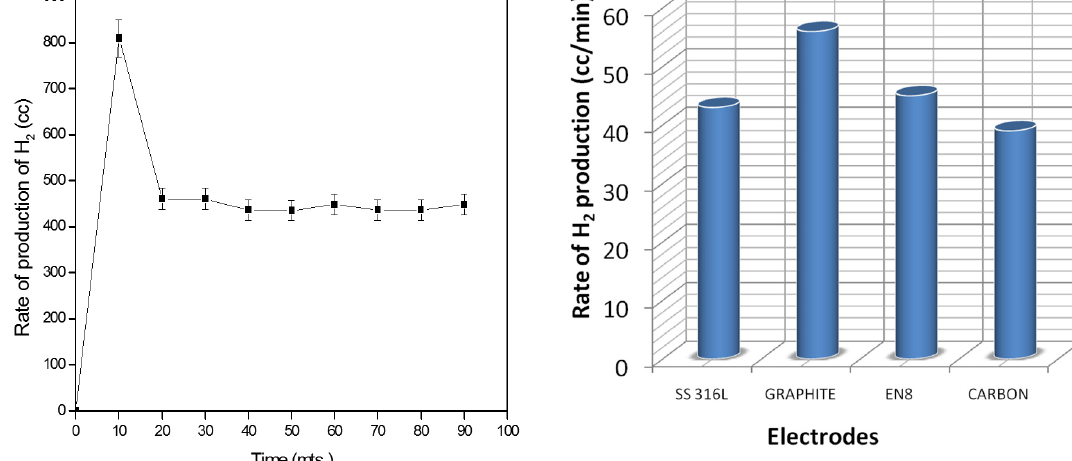
Figure 6. Effect of time on stream on the production of hydrogen gas: Dimensional of graphite rod: 80 × 20mm; Temperature: 303 K; Pressure: 1 atm; Electrolyte concentration: 0.03 M; Applied voltage: 12 V; Applied Current: 1.2 A; Distance between the electrodes: 2